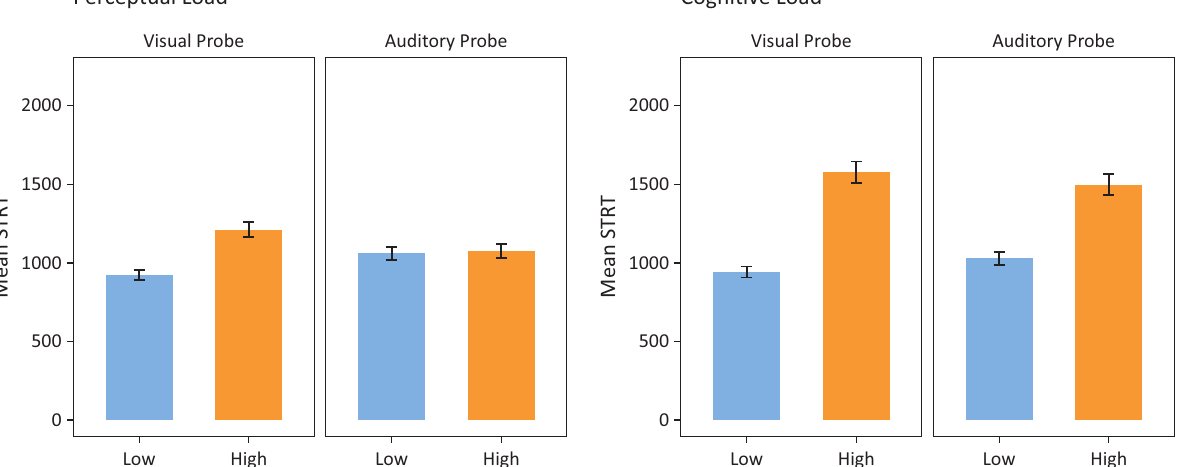
Figure 4. Interaction effects between perceptual load and modality (top) and between cognitive load and modality (bot- tom). There was an interaction between perceptual load and modality. The difference in STRTs between high and low perceptual load was 281.77 msec in the visual STRT condition and was 9.26 msec in the auditory STRT condition. There was not a significant interaction between cognitive load and modality. Error bars represent 95% confidence